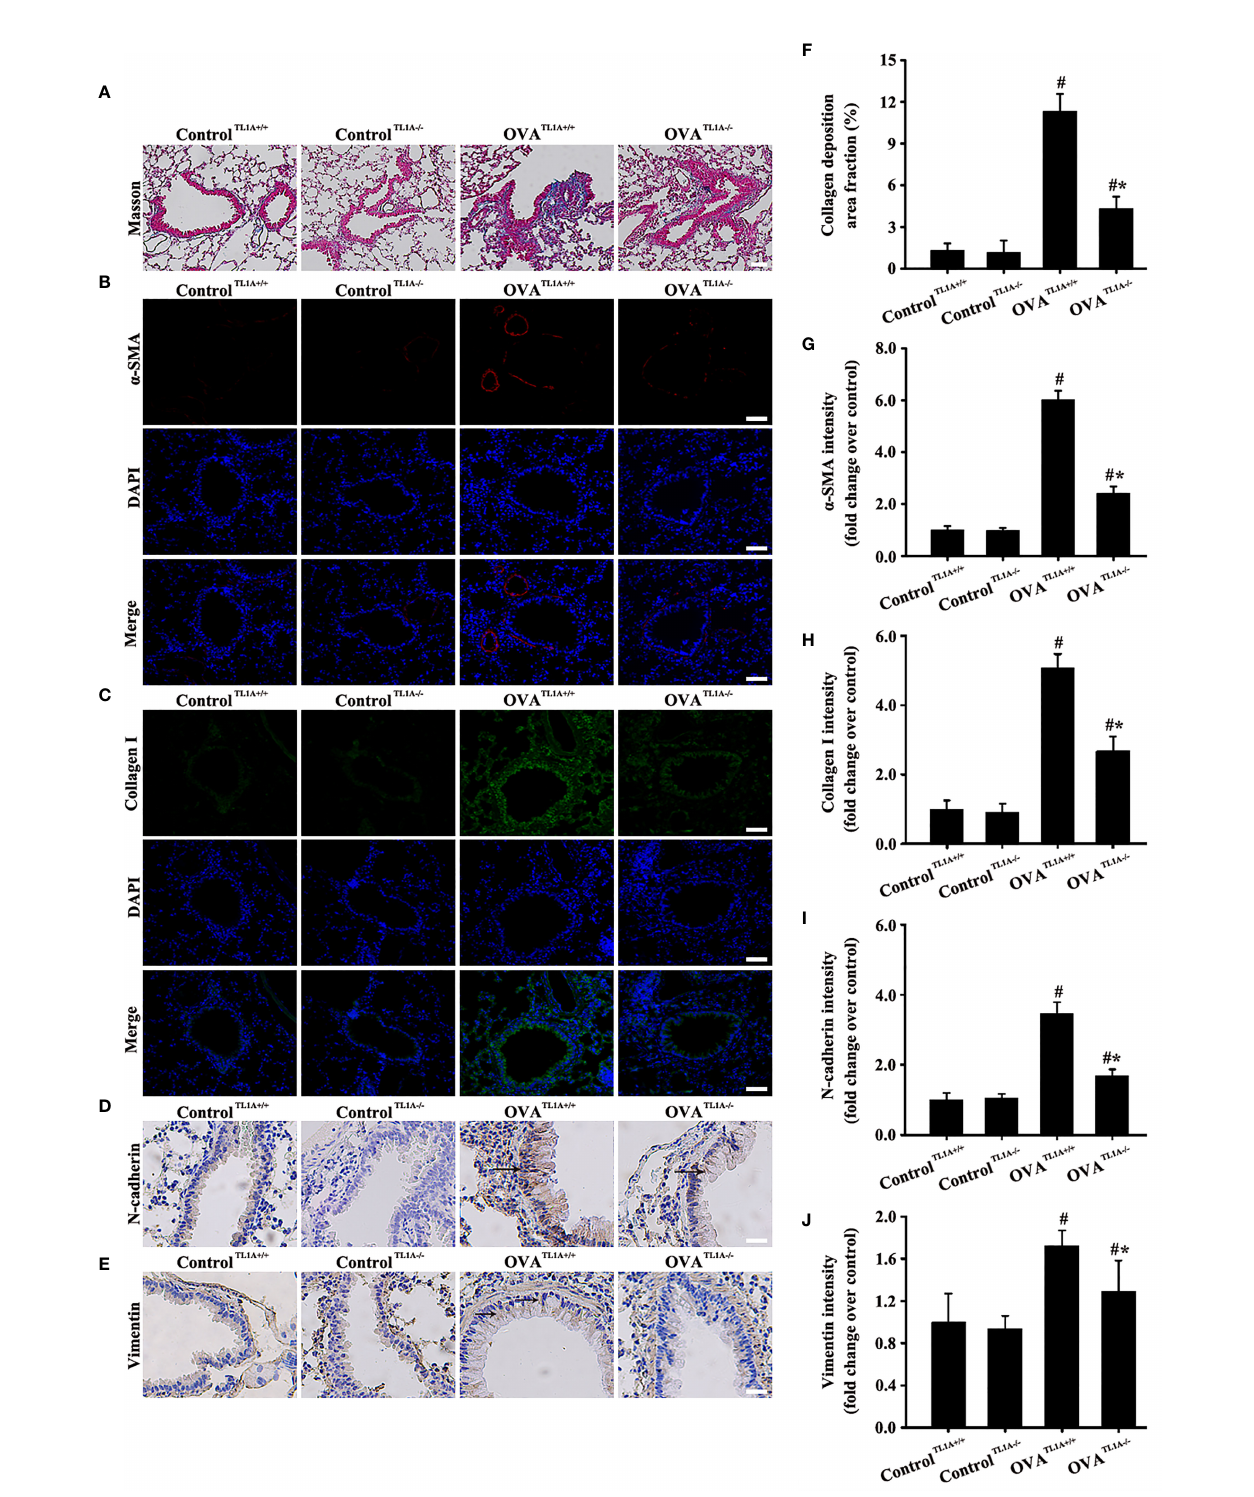
FIGURE 6 | Animal experimental schedule is shown in Figure 5A ( n = 6 in each group). Effects of the knockout TL1A gene on the EMT in mice were observed. The effects of the knockout TL1A gene on Masson (A) , a-SMA (B) , collagen I (C) , N-cadherin staining (D) , and vimentin staining (E) were detected. (A) : magni fi cation 100 ×, scale bar 100 µm. (B – E) : magni fi cation 200 ×, scale bar 50 µm. (F – J) intensity analysis of (A – E) . Data are expressed as the means ± SD for three independent experiments. # p < 0.05 versus the control group. # *p < 0.05 versus the OVA